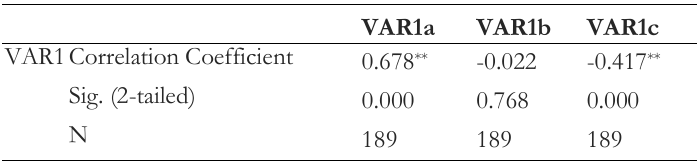
Table 2. Correlation among neutrosophic item 1 and classical item